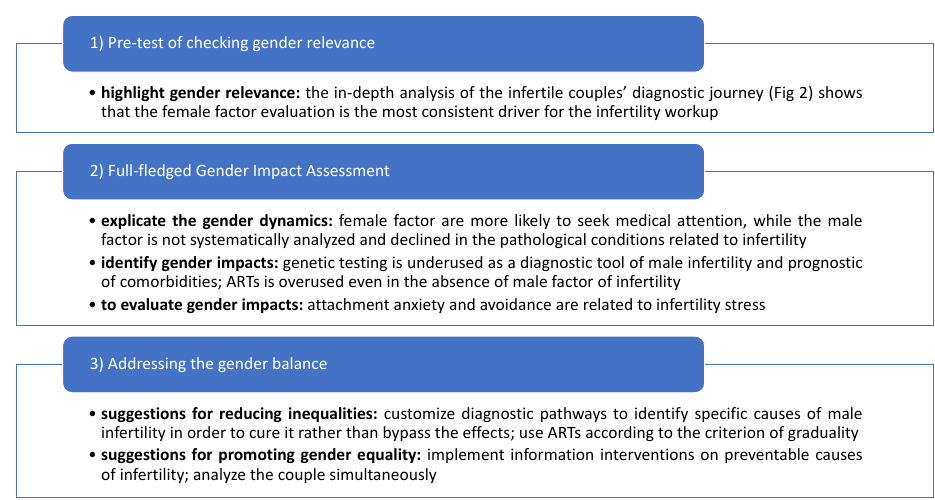
Figure 1. The steps of GIA applied to couple infertility. To obtain disaggregate data by sex, the diagnostic-therapeutic journey of infertility was analysed separately for males and females. Genetic tests, assisted reproduction techniques, and psychological factors were chosen as indicators to assess the gender impacts.